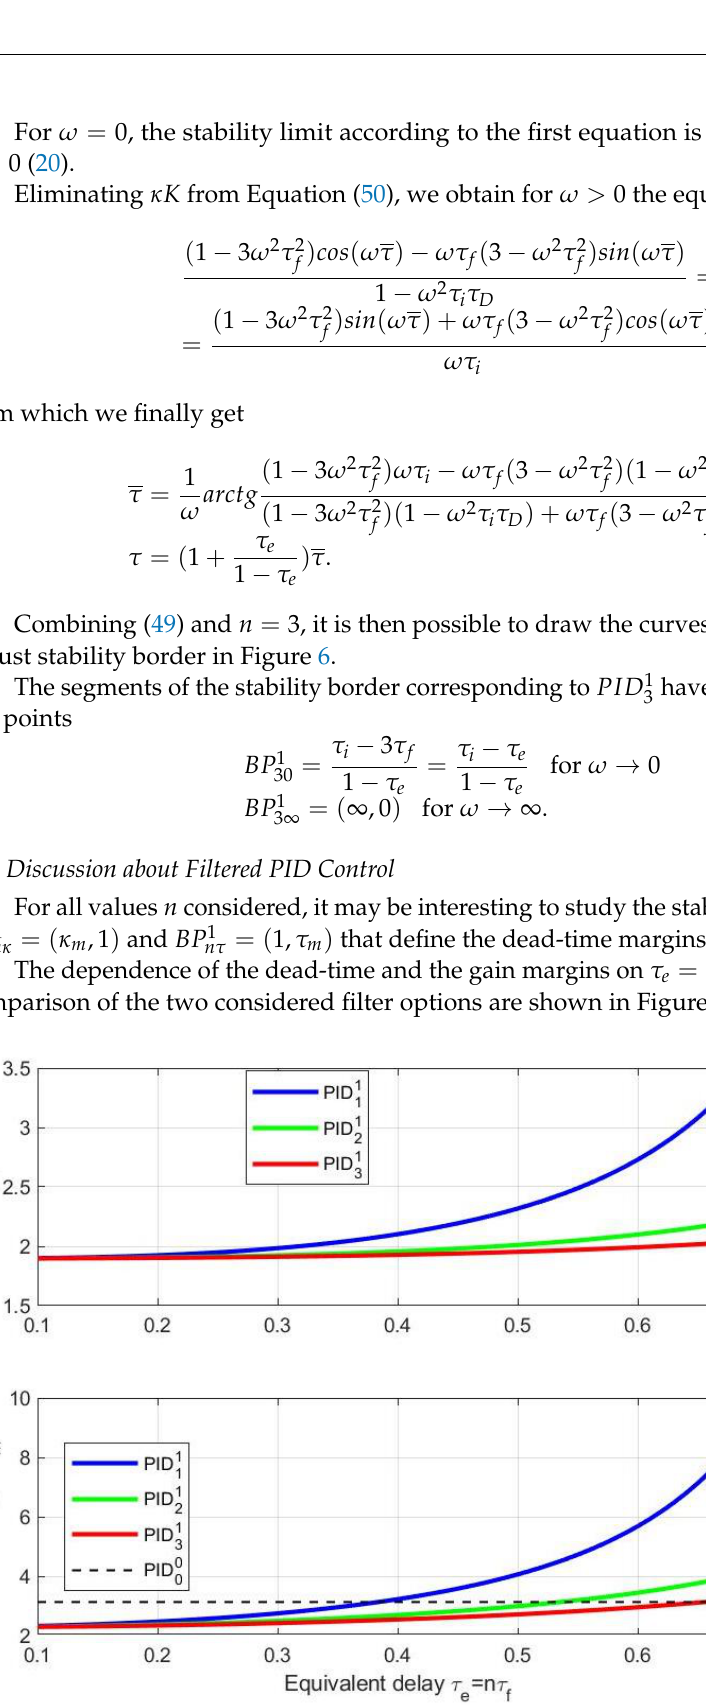
Figure 7. Calculating the gain margin κ m of the filtered PID 1 and the T f = T e / n tuning equivalence, n =